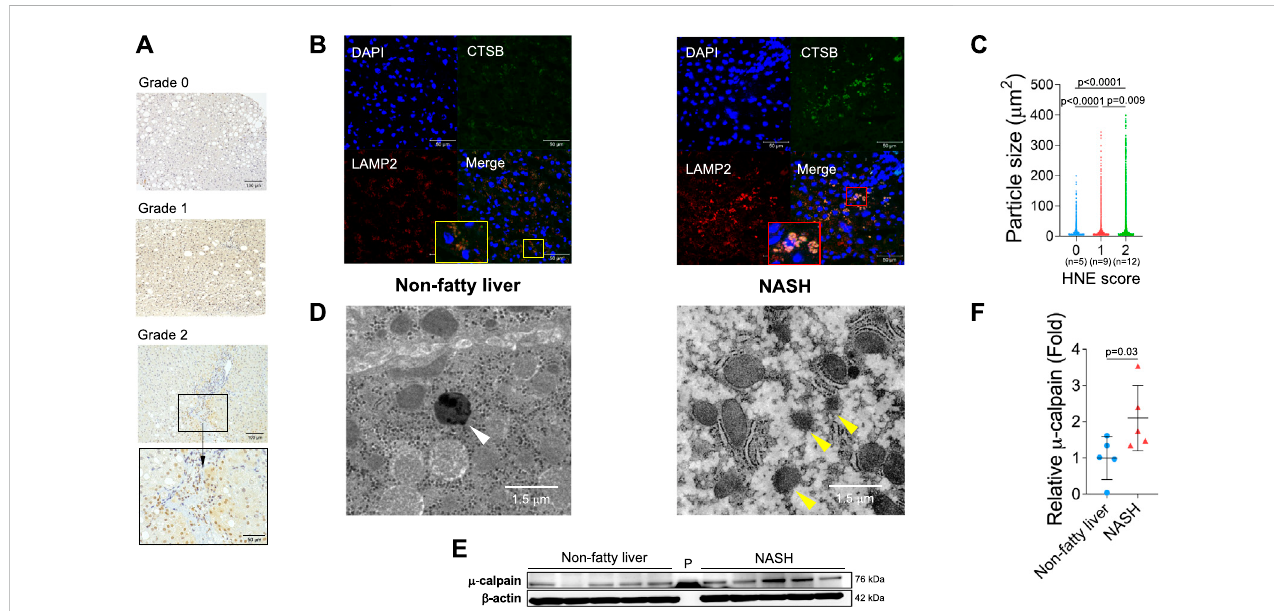
FIGURE 8 Hydroxynonenal(HNE)isinvolvedintheprogressionofdiseaseinhumanNASH.Panel (A) Semi-quantitativeassessmentofHNEimmunoreactivityintheliver tissue of patients with non-fatty liver disease (NAFLD). The density of HNE immunoreactivity was scored into 3 grades: no staining (Grade 0), weak and uniform staining (Grade1), and intense spots (rectangle) with uniform staining (Grade 2). Panel (B) Immuno fl uorescence staining of theliver tissue from patients with non- fattyliverandNASHshowsthatlysosomalmembranepermeabilization/rupturewasnegligibleintheformer(yellowrectangle),butoccurredremarkablyinthe latter(redrectangle). Blue,DAPI;green, cathepsinB(CTSB);red,Lamp-2.Panel (C) RelationshipbetweentheHNEstaining scoreanddouble-stainedgranulesizes for Lamp-2 and cathepsin (B) . Panel (D) Electron microphotographs of the non-fatty liver and NASH liver. Lysosomes with distinct limiting membrane structures were observed in the non-fatty liver (white arrowhead). In contrast, lysosomes in the NASH liver showed disintegrity of the lysosomal membrane